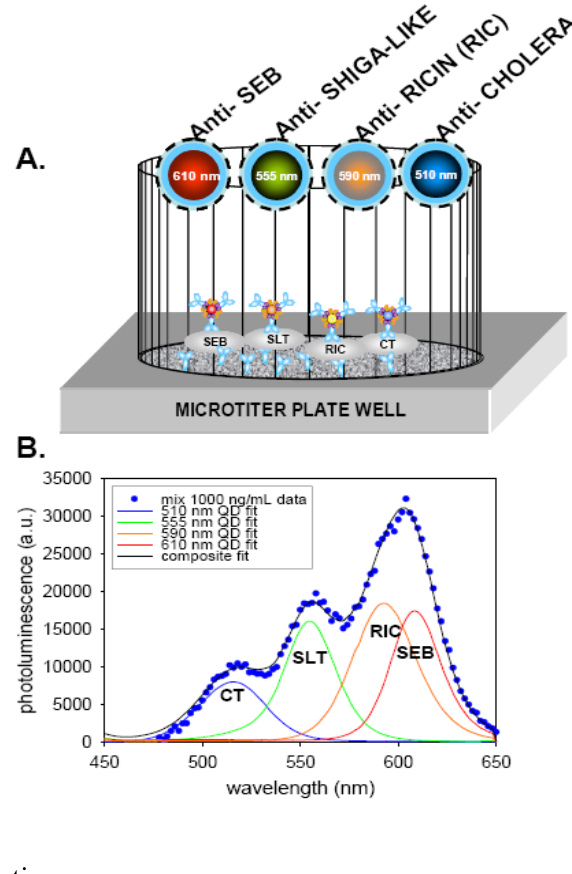
Figure 3. (A) Schematic of a 4-color multiplex assay. The indicated colors of QDs were prepared with antibodies against the 4-indicated toxins and simultaneously incubated in microtiter-well plates containing the 4-toxins immobilized by capture antibodies on the surface. (B) Multi-toxin assay examining mixes of all four indicated toxins at 1000 ng/mL each probed with a mix of QD-detection antibody conjugates. Measured values are shown as circles. Both the composite fit and the fit from each of the four individual QD components are displayed. Reproduced from